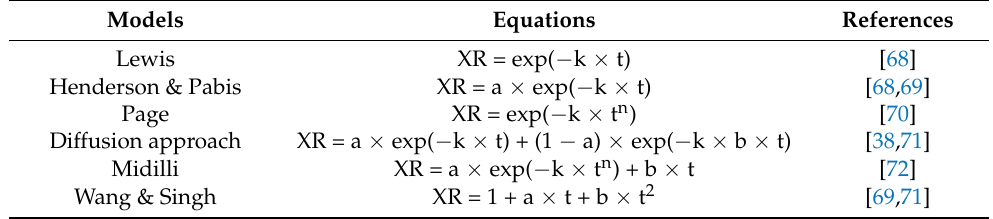
Table 4. Mathematical models adjusted to the drying curves of Lippia thymoides